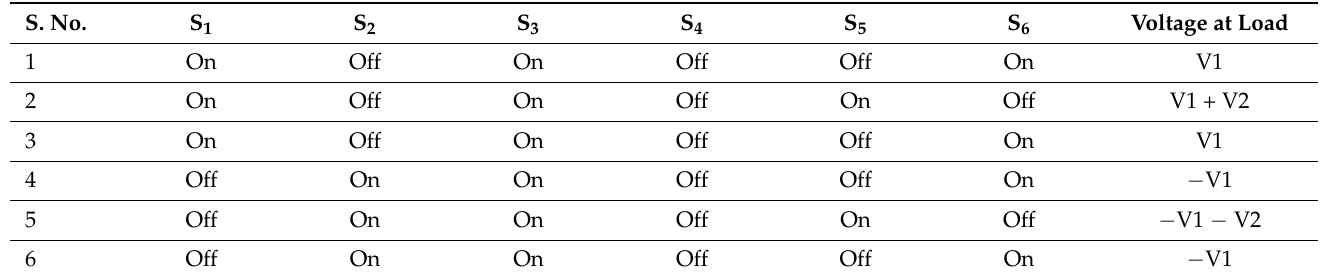
Table 5. Switching states of proposed multilevel inverter.